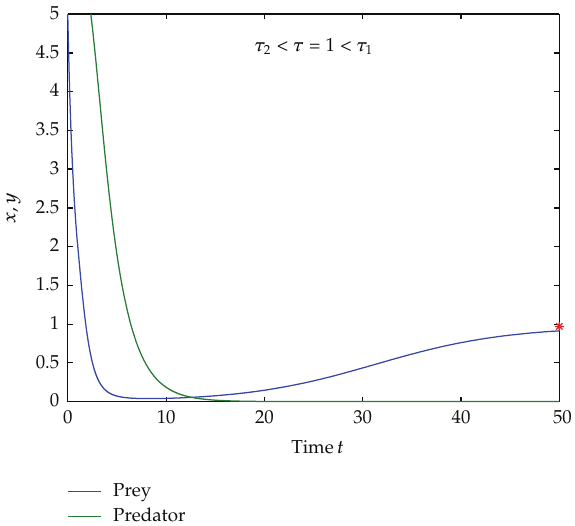
Figure 2: The equilibrium E 1 is globally stable when τ (cid:6) 1.